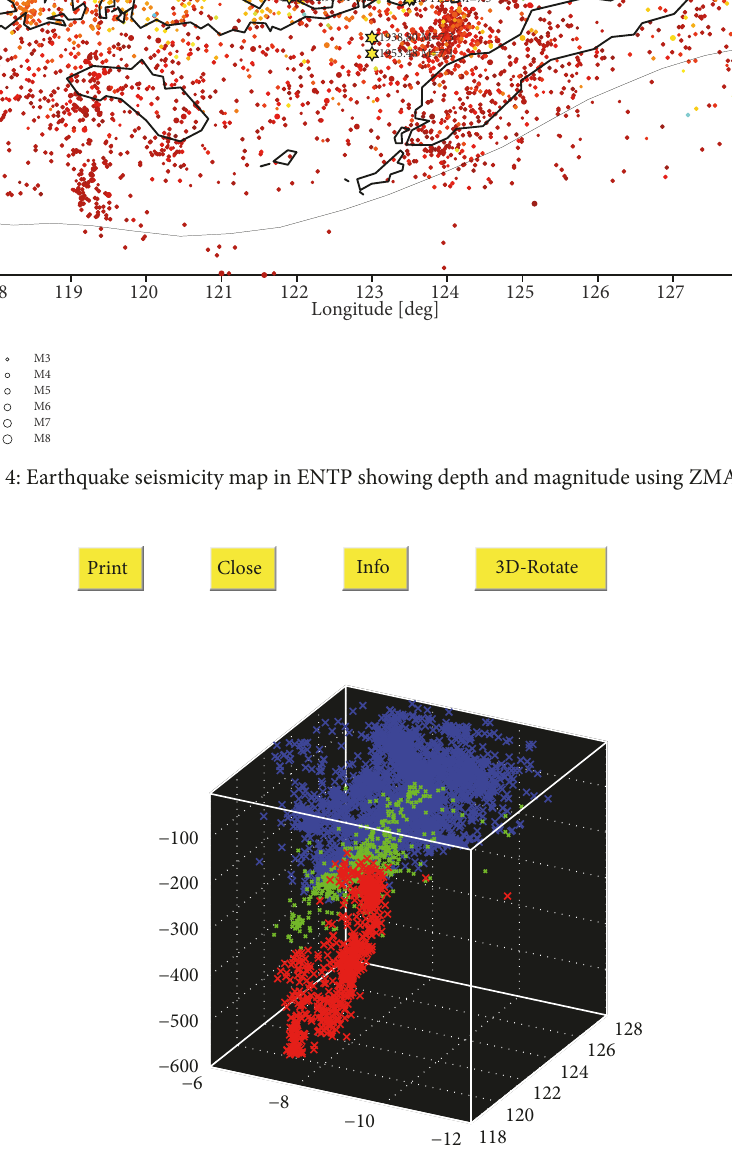
Figure 5: The 3-dimension map of earthquake distribution in ENTP using ZMAP